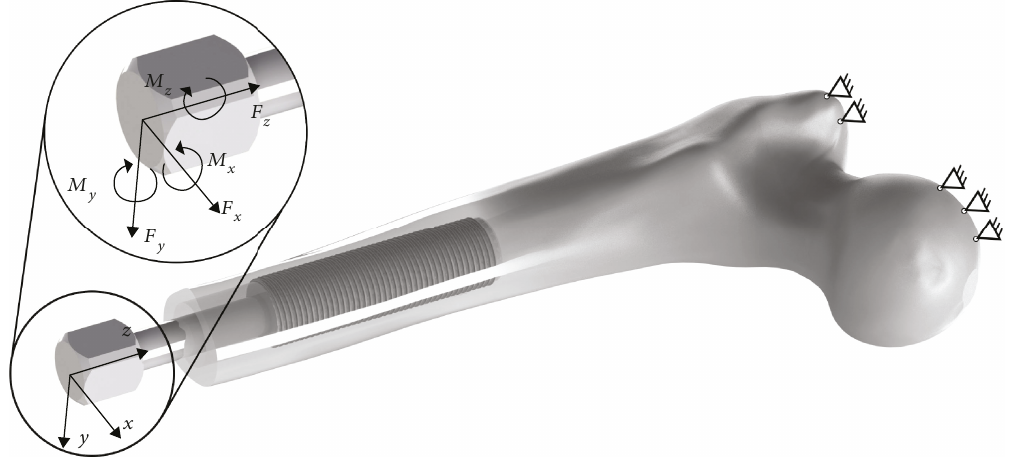
Figure 2: The implantation method, considered coordinate system for loads, load location, and the positioning of supports.